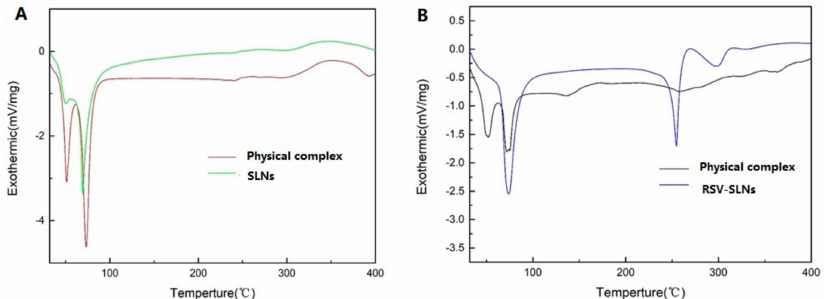
Figure 2. DSC heating curves of physical complex SLNs and SLNs ( A ); physical complex RSV-SLNs and RSV-SLNs ( B ) from 0 to 400 ◦